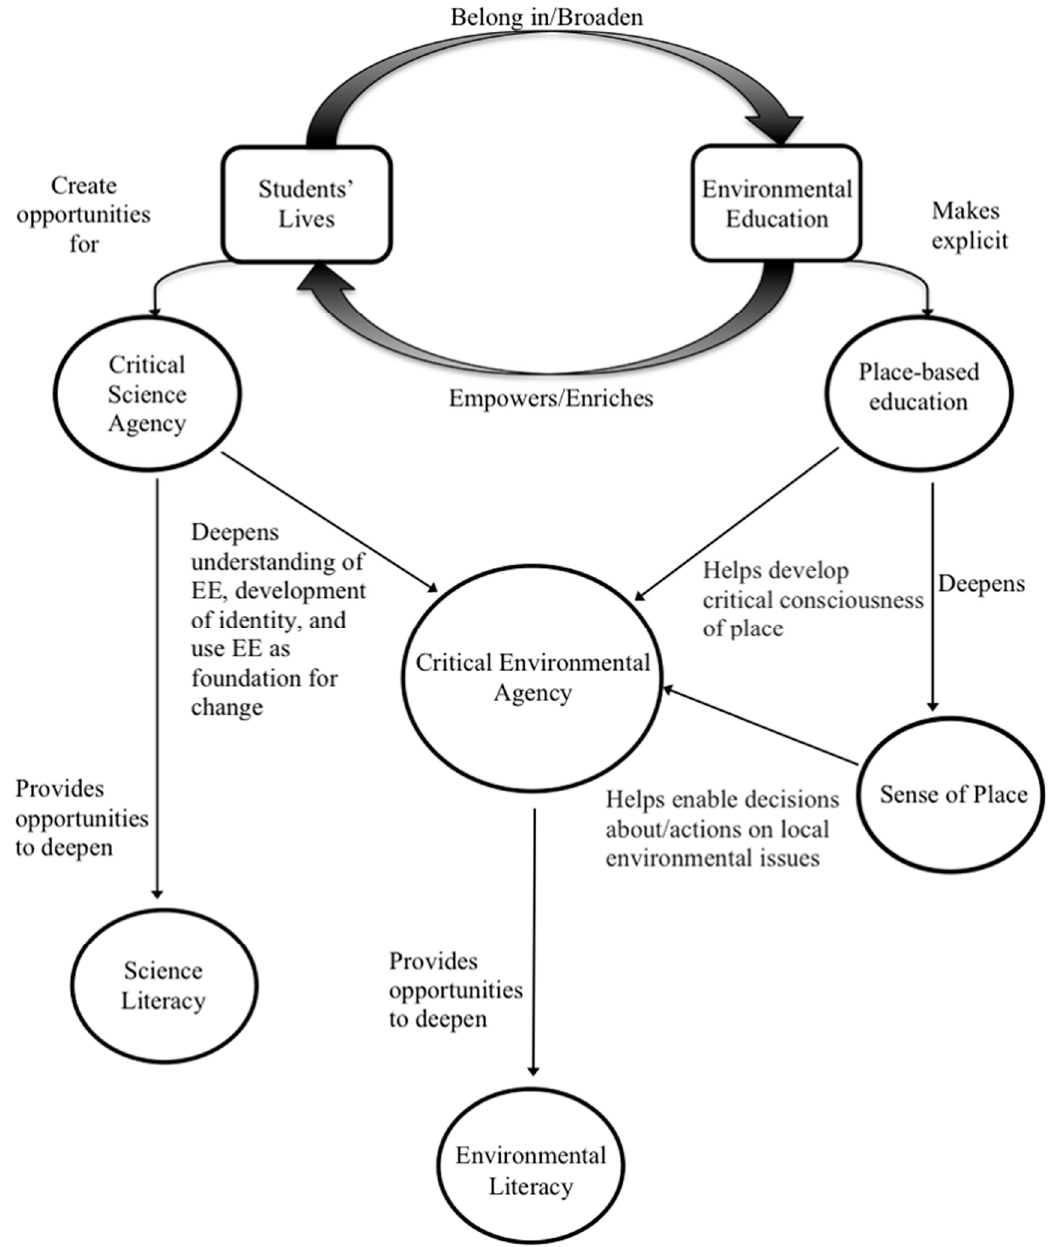
Figure 1. Conceptual framework for critical environmental agency.